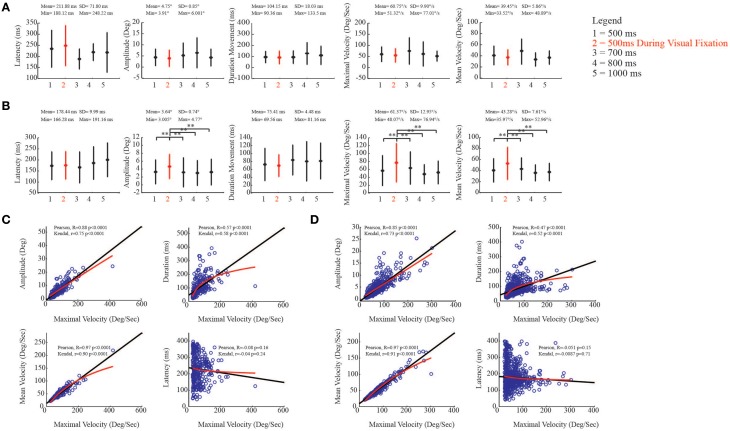
Kinematic study of the evoked ear movements. (A) Plots put in relation ear kinematic parameters of the core region with the duration of stimulation (numbers on x-axis), during visual fixation task (red), and spontaneous conditions (black). The descriptive statistic shows data which are means ± SEM of 386 determinations; **p < 0.05. Min corresponds to the average minimum value within the 5 conditions. Max corresponds to the average maximum value within the 5 conditions. (B) Plots put in relation ear kinematic parameters of the belt region with the duration of stimulation (numbers on x-axis), during visual fixation task (red), and spontaneous conditions (black). Latency, movement amplitude, movement duration, maximal and mean velocities are studied. Data are means ± SEM of 974 determinations; **p < 0.05. (C) Correlation analysis in the core region. Black line represents Pearson correlation, while red line represents non-linear regression (Kendall). Maximal velocity (x-axis) is compared with remaining kinematic parameters (y-axis). (D) Correlation analysis in the belt region.